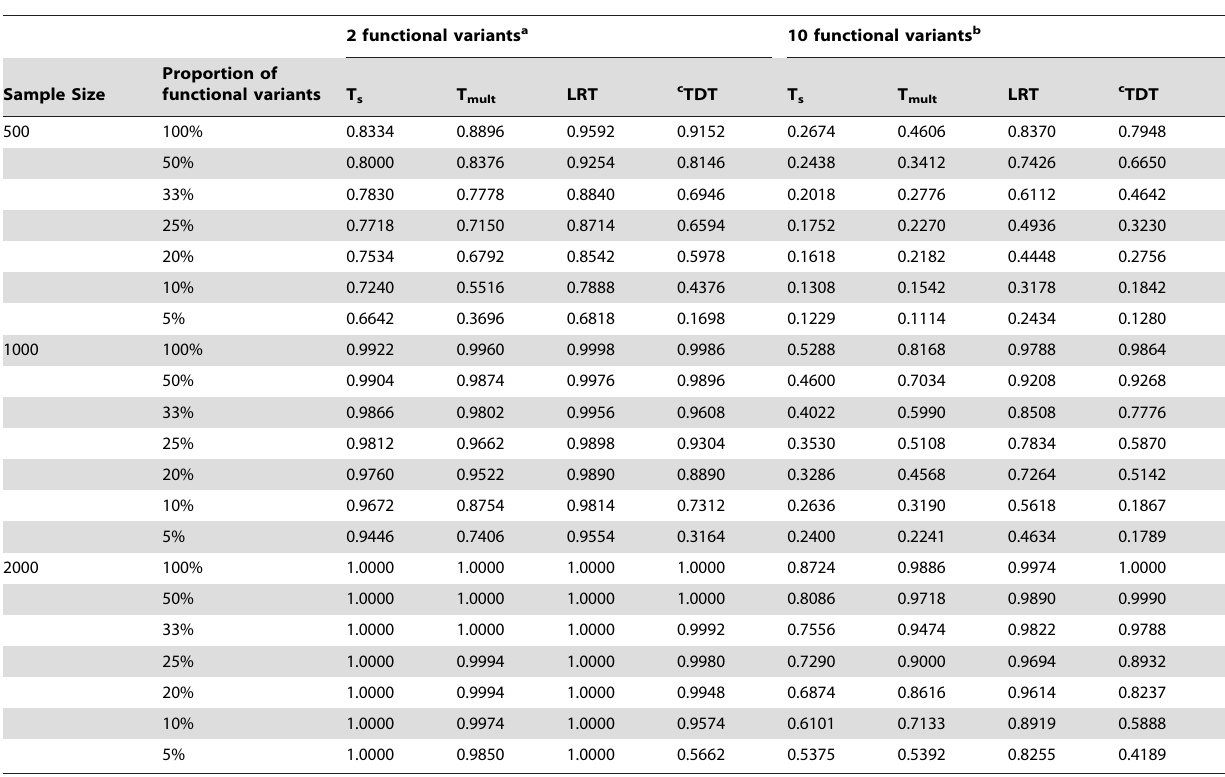
Table 2. The power of the tests when nonfunctional rare variants are included.